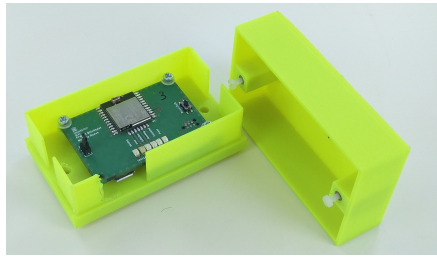
Figure 2. Designed detection node in its fluorescent housing.